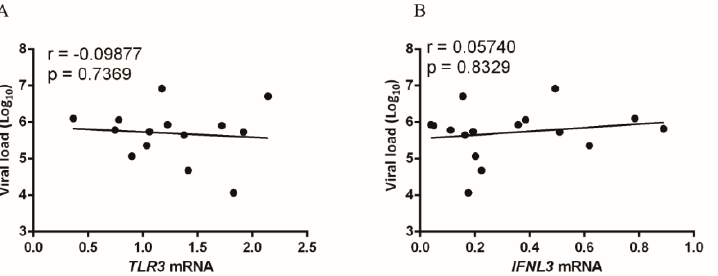
Figure 2. Plasma viral load of patients and its correlation with the intrahepatic expression of TLR3 ( A ) and IFNL3 ( B ). Pearson linear correlation.